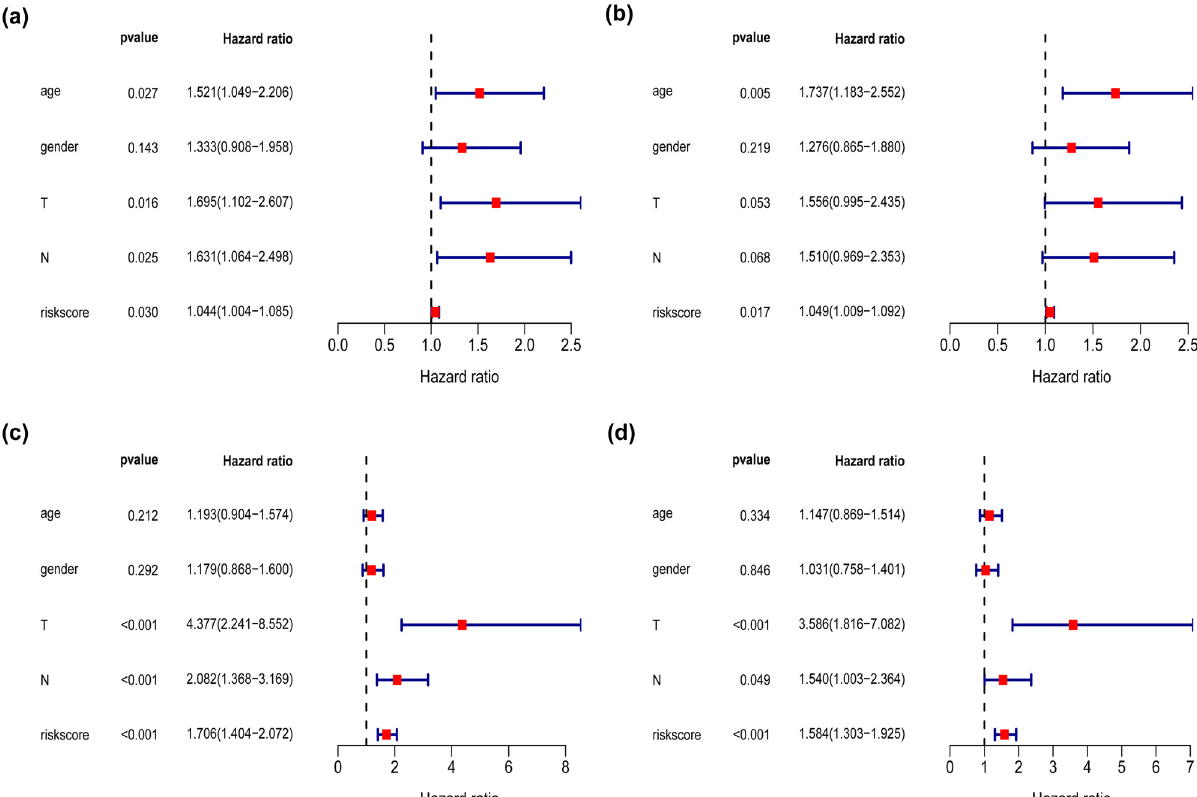
Figure 4: Univariate analysis and multivariate analysis of the correlation of the signature of nine immune - relevant genes with OS among GC patients in the TCGA cohort ( a + b ) and GSE84437 cohort ( c + d )